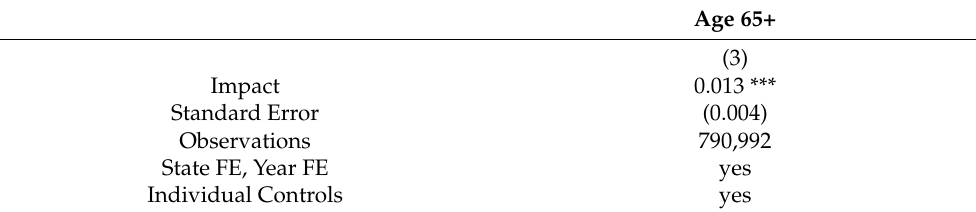
Table A1. Impact of explicit vaccination authority for pharmacists on influenza vaccine uptake rate,